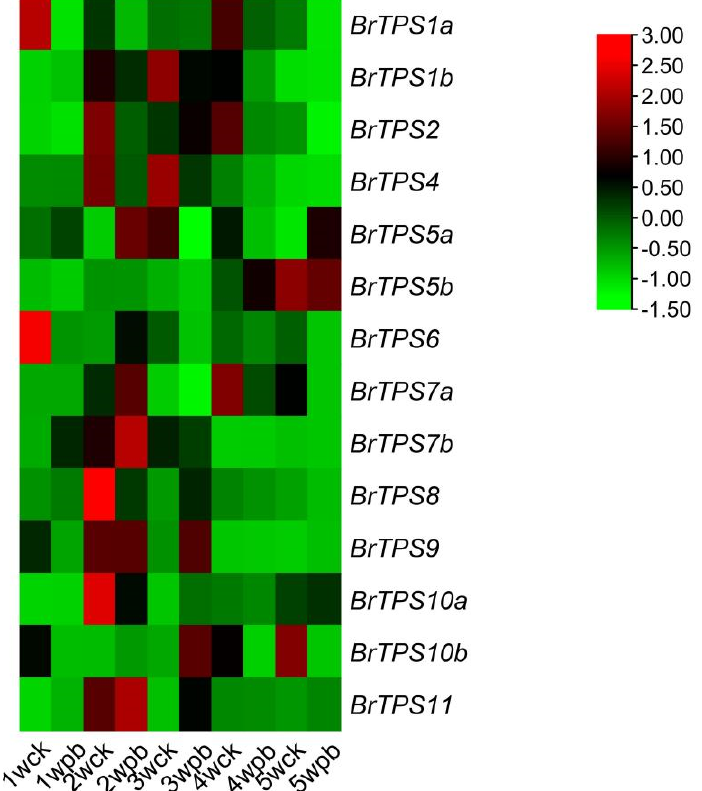
Figure 7. Relative Expression profiles of BrTPS genes in the Chinese cabbage root after of P. brassicae . infection. CK represents inoculation with water; Pb represents inoculation with P. brassicae . Expression of each BrTPS gene was measured by qRT-PCR from 1 week to 5 weeks post-inoculation. The expression levels of genes are presented using fold change values transformed to Log2 format. The data indicate the relative expression levels normalized to that of the internal control 18srRNA . Red and green colors correspond to up- and downregulations of the BrTPS gene expressions, respec- tively.